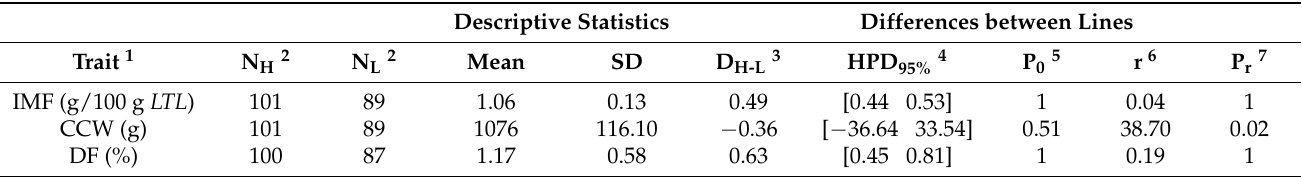
Table 1. Descriptive statistics and differences between lines of meat and carcass quality traits. Descriptive